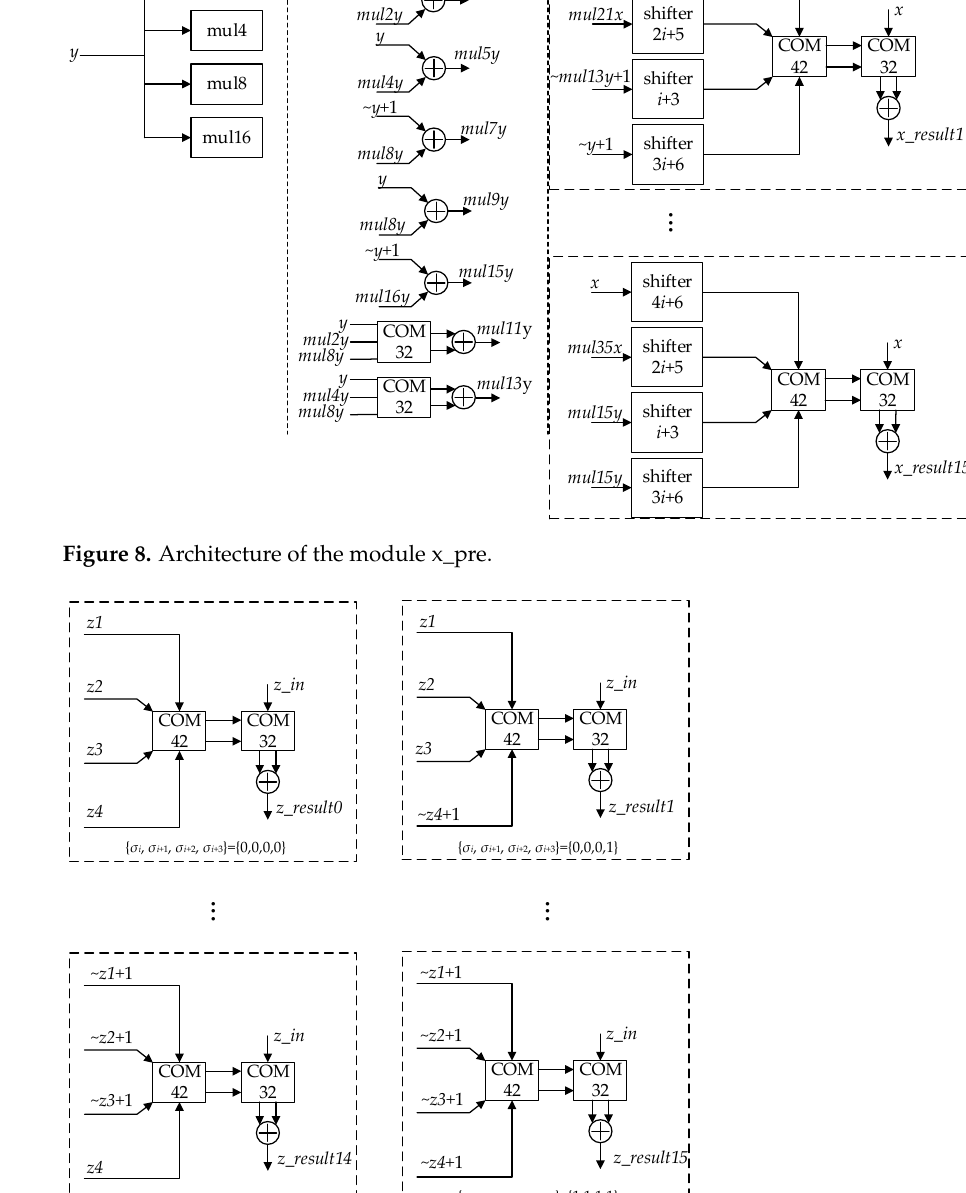
Figure 9. Architecture of module z_pre.